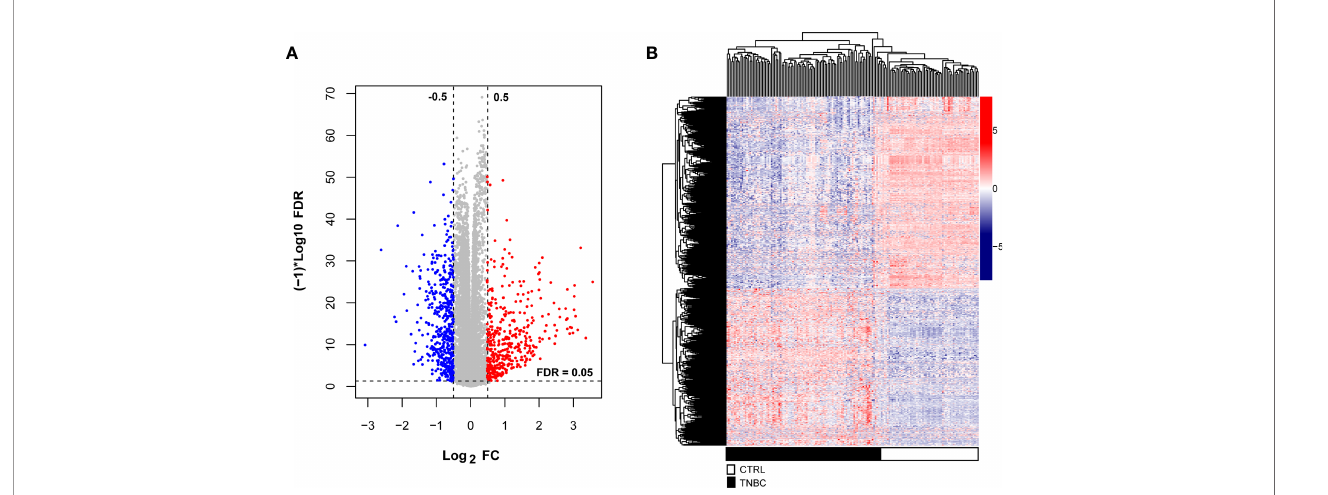
FIGURE 1 | Differentially expressed RNAs, including lncRNAs, miRNAs and mRNAs, from the TCGA dataset. (A) The volcano map was constructed. The blue and red dots indicate signi fi cantly downregulated and upregulated differentially expressed RNAs, respectively. The horizontal dotted line indicates an FDR < 0.05, and the two vertical dashed lines indicate a | log2FC | > 0.5. (B) Bidirectional hierarchical clustering heat map based on the levels of differentially expressed RNAs; the black and white sample bars represent TNBC and control peritumoral tissue patients,